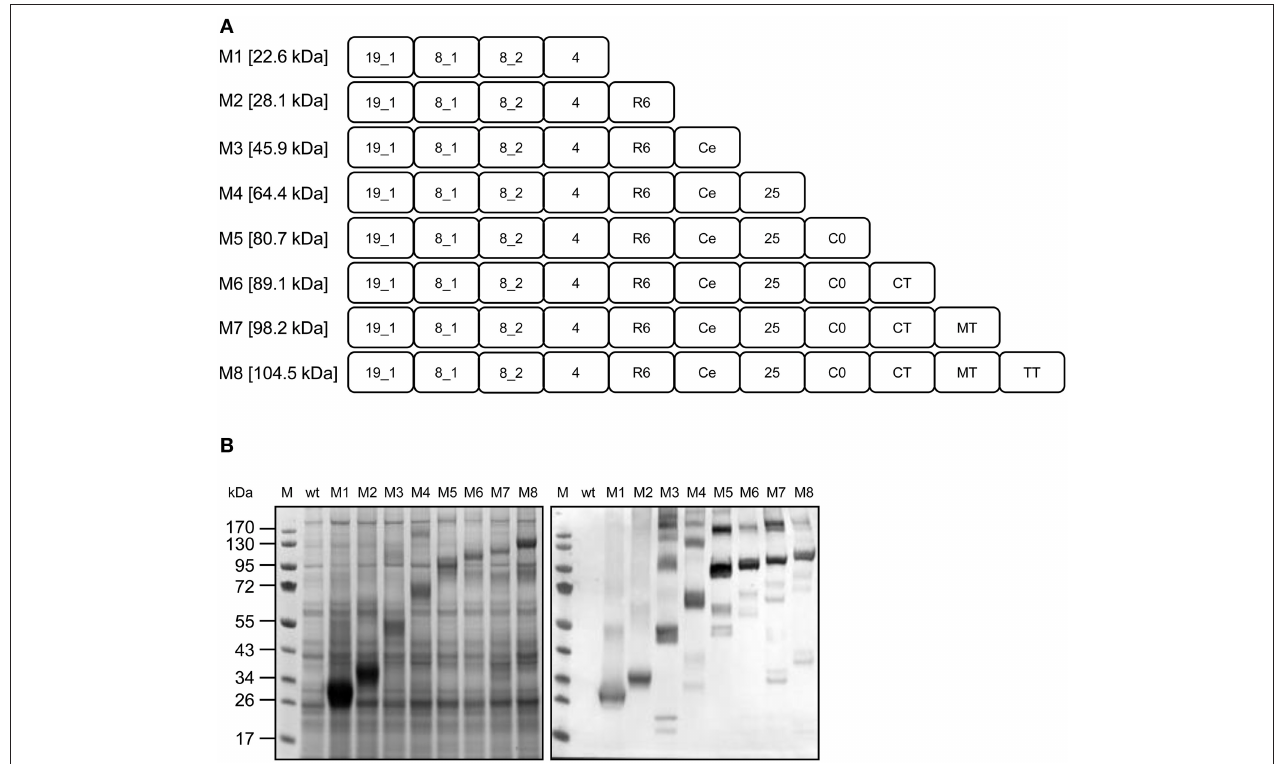
FIGURE 9 | Construction and expression of the multi-domain, multi-stage vaccine candidate (variants M1–M8). (A) Construct architecture. For antigen abbreviations refer to Table 1 . (B) SDS-PAGE and western blot analysis of multi-domain, multi-stage candidate variants. Heat-treated crude extracts were separated under reducing conditions and analyzed by staining with Coomassie (left panel) or by western blot using rabbit anti-His 6 and alkaline phosphatase-labeled goat anti-rabbit antiserum. M, PageRuler TM pre-stained protein ladder (Fermentas); wt, non-infiltrated leaf